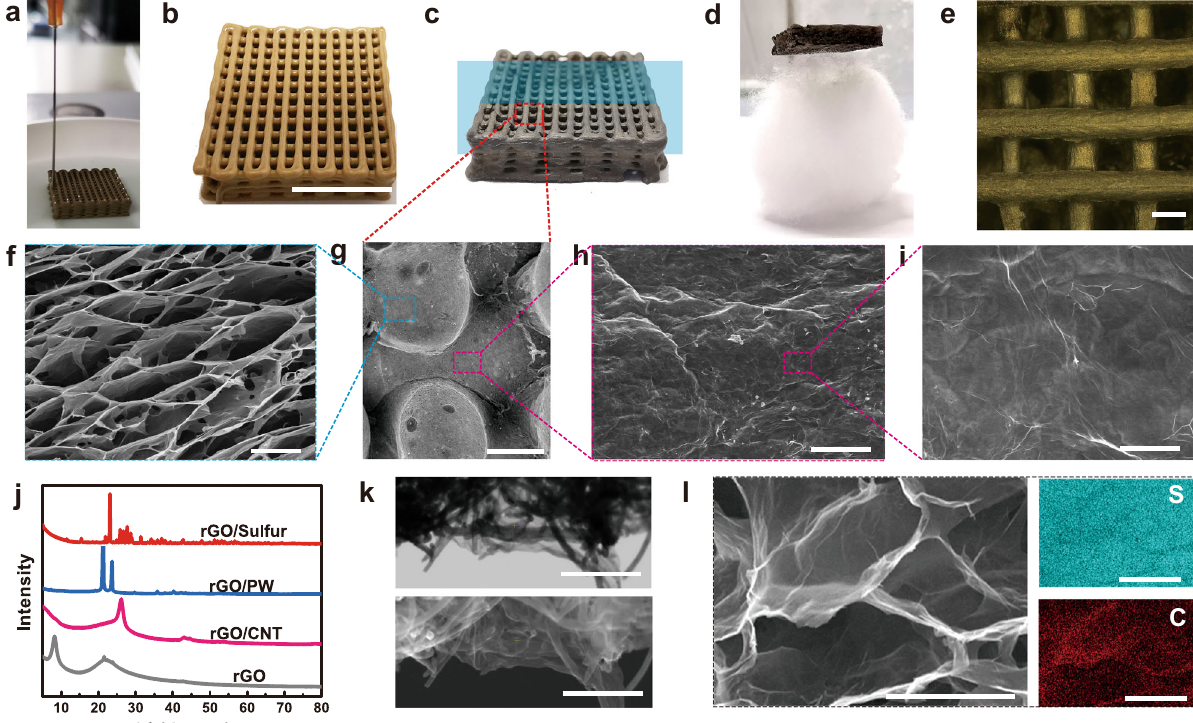
Fig. 3 Morphology and characterization of nanomaterial matrices and their hybridization. a – d Images of a direct ink writing conduced on GO 1.0% /DDAB- IB inks, b printed woodpile scaffolds sustained in air, c graphene aerogels, and d ultralight graphene aerogels with a density of ∼ 6 mg cm − 3 . e OM image of layer-by-layer stacking woodpile structure. f – i Scanning electron microscope (SEM) cross-sectional images ( f , g ) and surface images ( h , i ) of fi laments in the printed woodpile. j X-ray diffractometry spectra of annealed 3D GO aerogels and 3D GO composites that include rGO/CNT and rGO/PW and rGO/ Sulfur. k Transmission electron microscope (TEM) image and SEM image of rGO/CNT. l SEM image of GO/Sulfur and element mapping of S and